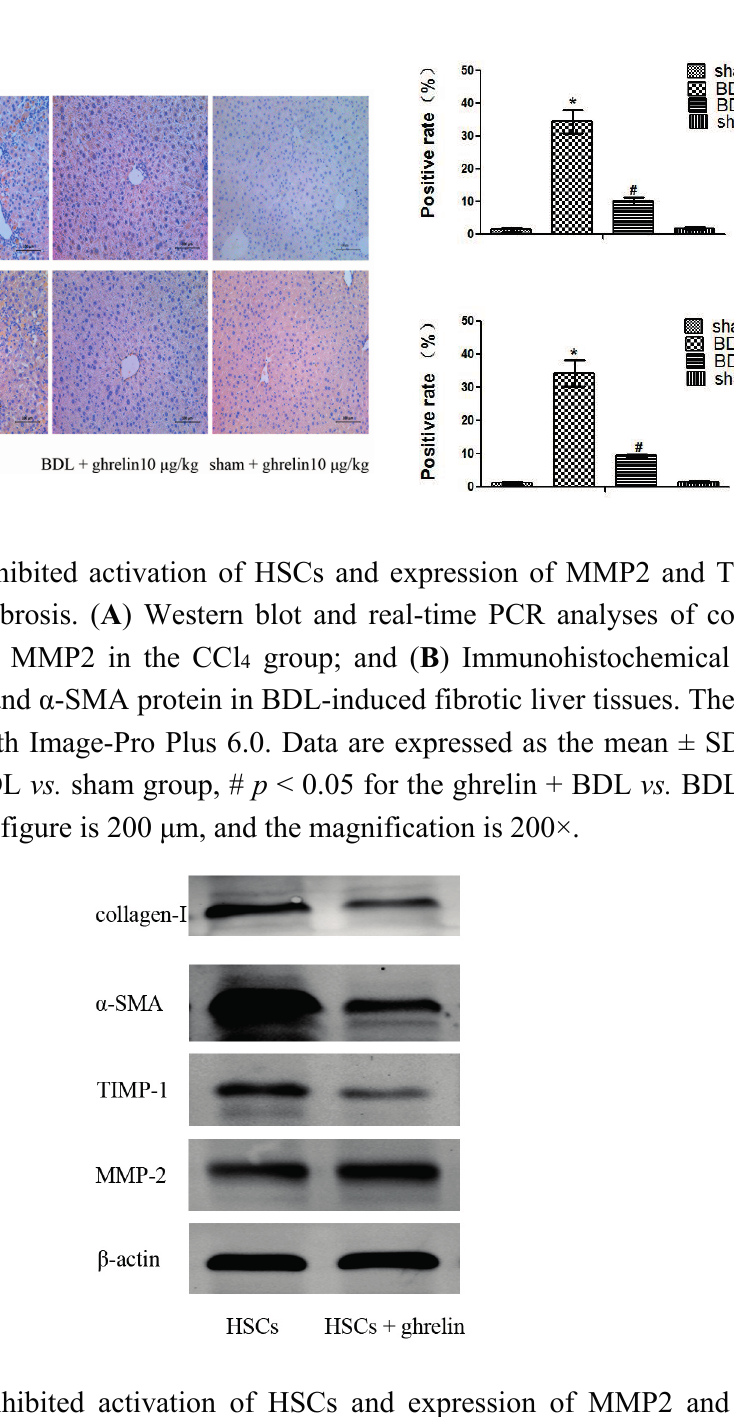
Figure 4. Ghrelin inhibited activation of HSCs and expression of MMP2 and TIMP1. Western blot analysis of collagen I, α -SMA, TIMP1 and